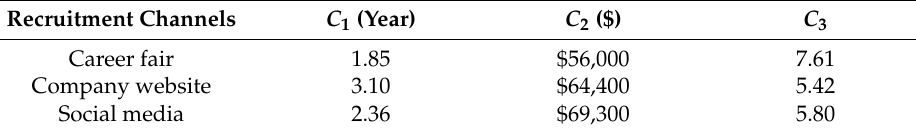
Table 3. Decision matrix for evaluating recruitment channels.